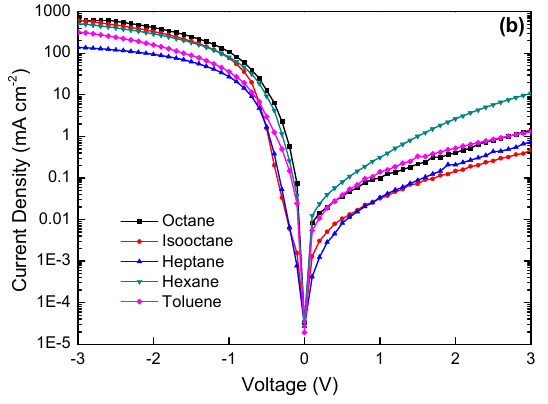
Figure 3. J – V characteristics of PbS/TiO 2 solar cells fabricated by using different single solvent ( a ) under light ( b ) under dark. Table 2. Photovoltaic parameters obtained from the J–V curves (Figure 3a) for solar cells with different single solvent.